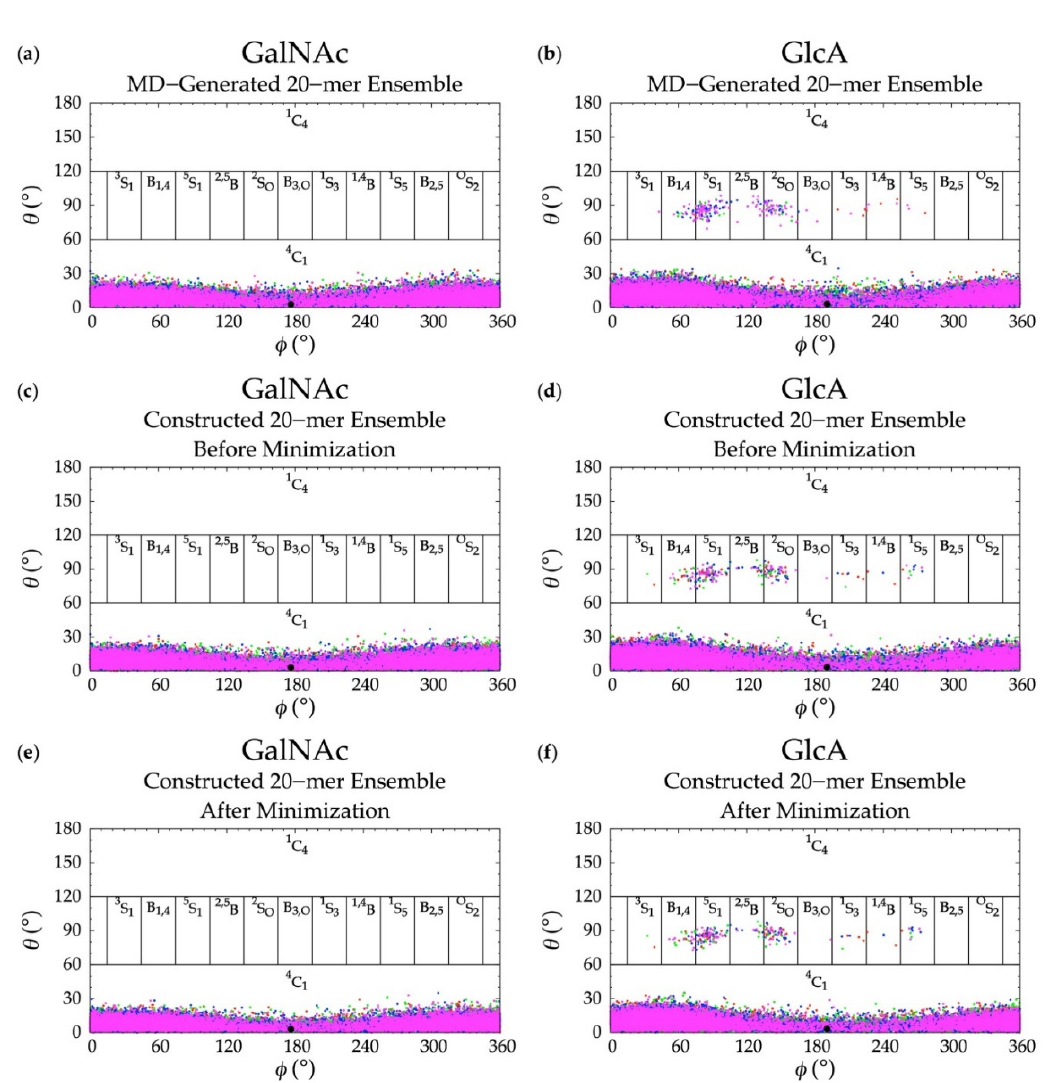
Figure 4. Cremer–Pople data for GalNAc and GlcA in ( a , b ) MD-generated ensembles and constructed ensembles ( c , d ) before and ( e , f ) after energy minimization; geometries from the four sets of each type of ensemble are represented by red, green, blue, and magenta dots, respectively and the force-field geometry is represented by a single large black dot. Cremer–Pople parameters ( φ , θ ) for all rings in every tenth snapshot from each ensemble were plotted (i.e., 10 rings * 1,000 snapshots per run * 4 runs = 40,000 parameter sets). As the algorithm reads all ring conformations sampled in MD, not all datapoints in panels ( c – f ) are seen in panels ( a , b ) but the full MD-generated dataset contains all datapoints in the constructed ensembles.